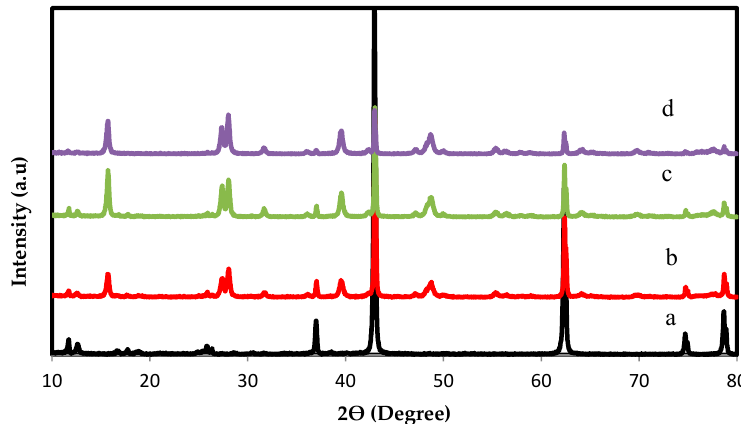
Figure 1. XRD patterns of the catalysts: ( a ) Pt,Pd,Ni / MgO, ( b ) Pd,Pd,Ni / Mg 0.97 La 3 + 0.03 O, ( c ) Pd,Pd,Ni / Mg 0.93 La 3 + 0.07 O, ( d ) Pd,Pd,Ni / Mg 0.85 La 3 + 0.15 O. Table 1. Results of the particle size measurement by XRD, TEM, and XRF.